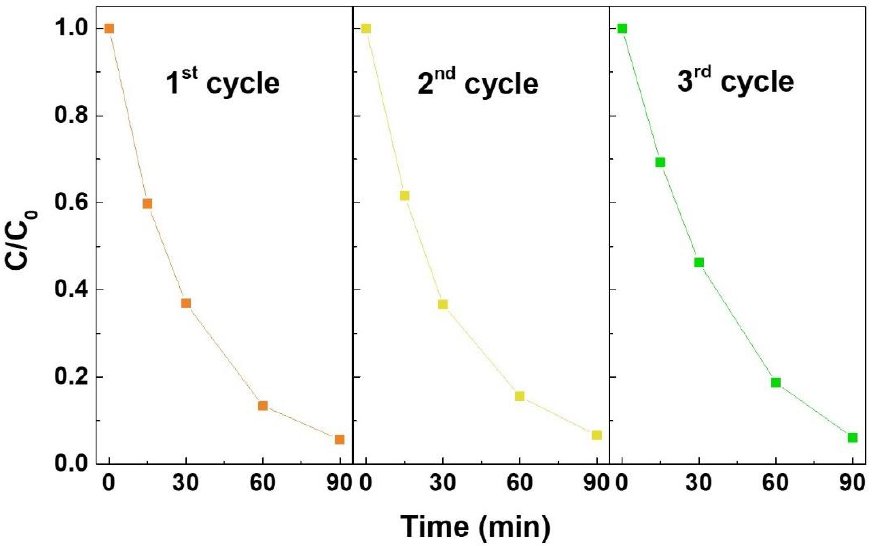
Figure 7. C/C 0 comparison of the photocatalytic degradation of RhB under sunlight in the presence of Zn 2 SnO 4 nanoparticles (10 min of synthesis duration). The lines are for eye guiding only.